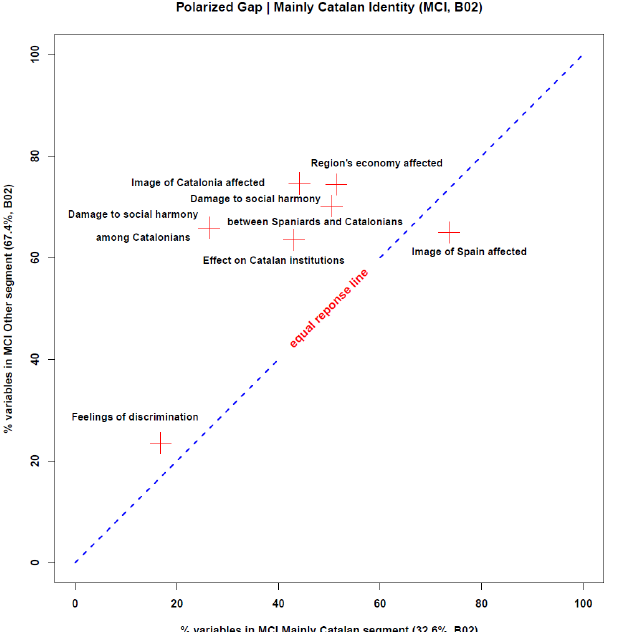
Figure 5. “Polarized gap” plot showing the most relevant differences distinguishing participants self-identifying as “mainly Catalan” with respect to the other “ feelings of national identity ” via several variables. The population was segmented into two groups according to their feelings of national identity: “ mainly Catalan identity ” (responders with either “only Catalan” or “more Catalan than Spanish” identities) versus the opposite segment. Each variable is represented by a red cross. The further each variable is from the bisector of the figure, the more different the opinions that each group had with respect to it. Thus, for the variable “ damage to social harmony among Catalonians”, the “ mainly Catalan identity ”’ group agreed in 26.4% of the cases, compared to 65.9% in the group with other feelings of national